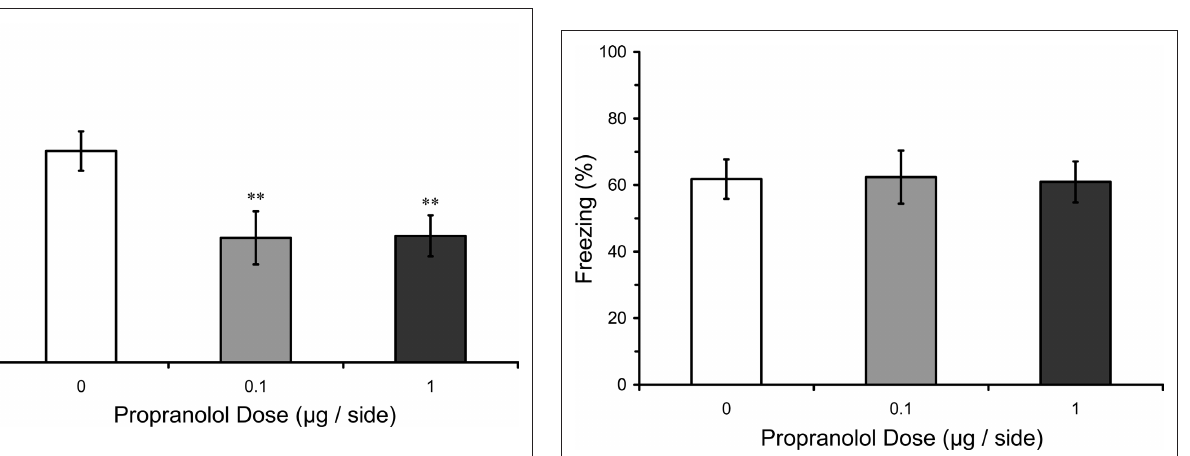
Figure 6 | Pre-testing propranolol does not affect fear expression. Rats from Experiment 4 were fear conditioned, and then 2 days later given no effect on fear memory expression. The figure depicts mean freezing levels during the expression test.